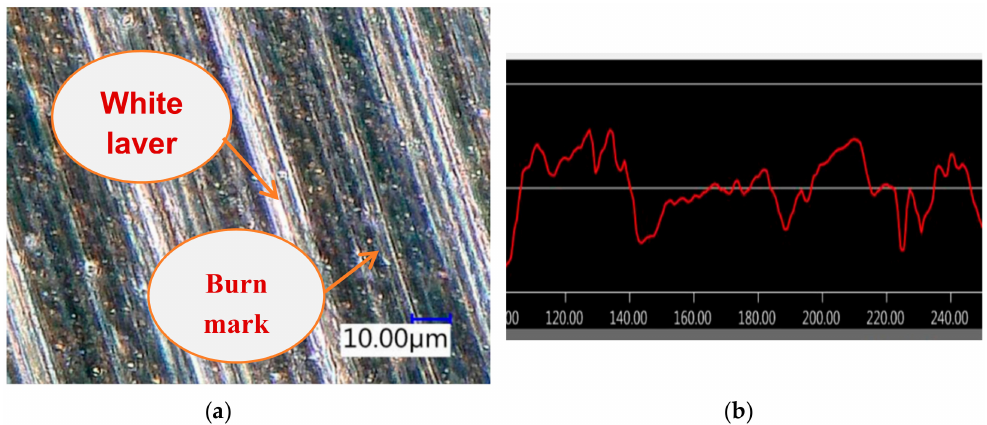
Figure 9. Microstructure ( a ) and profile ( b ) of machined surface under dry condition.